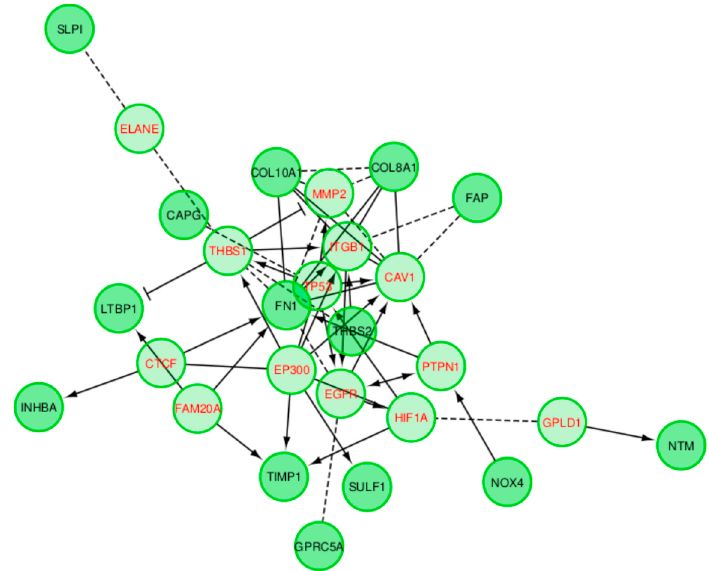
Figure 12. Reactome Functional Interaction visualization of the PDAC dataset. Dashed edges are predicted associations. Directional edges indicate regulation, and T junction edges represent inhibition.